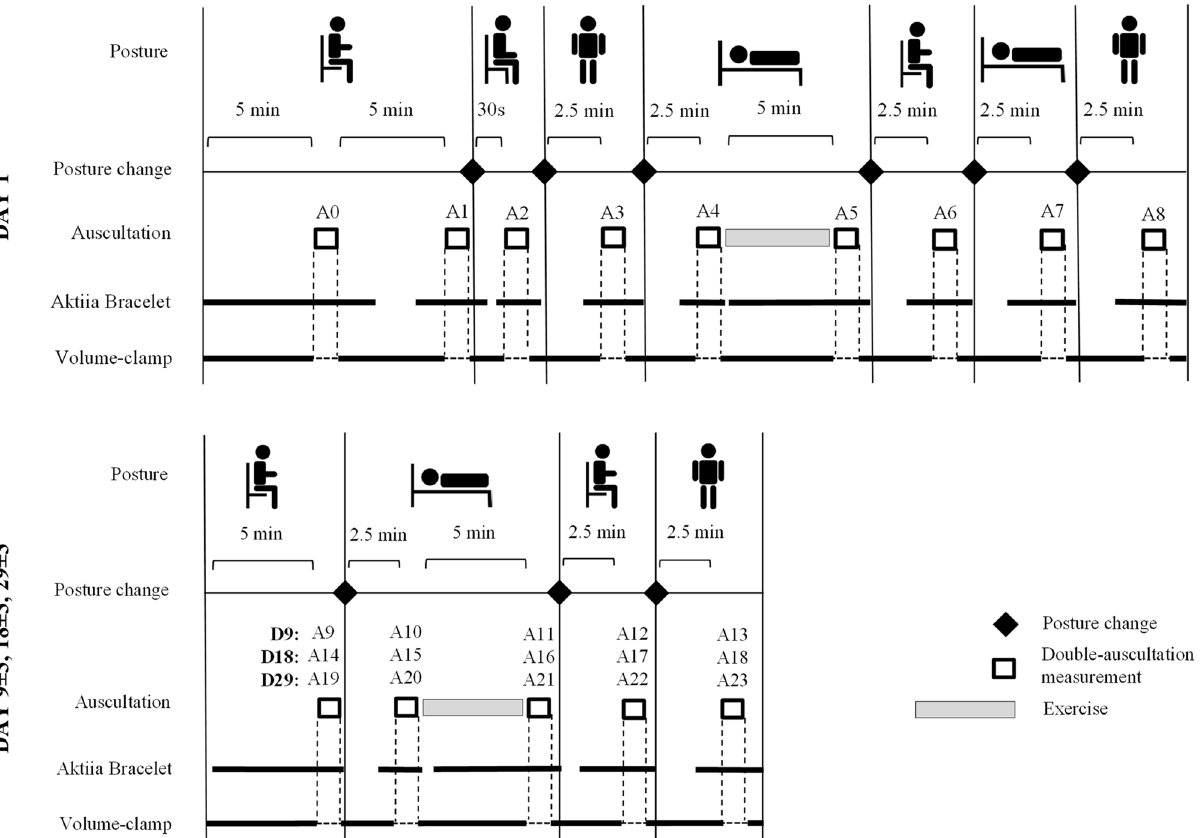
Figure 2. Schematic representation of the protocol designed to evaluate the performance of a cuffless BP monitor intended to be used in 24/7 environments. At each visit, assessments involving the reference device and the device under test are performed in varying body positions such as sitting, lying and standing positions, and after exercise. Visits are further repeated in order to test the stability of the